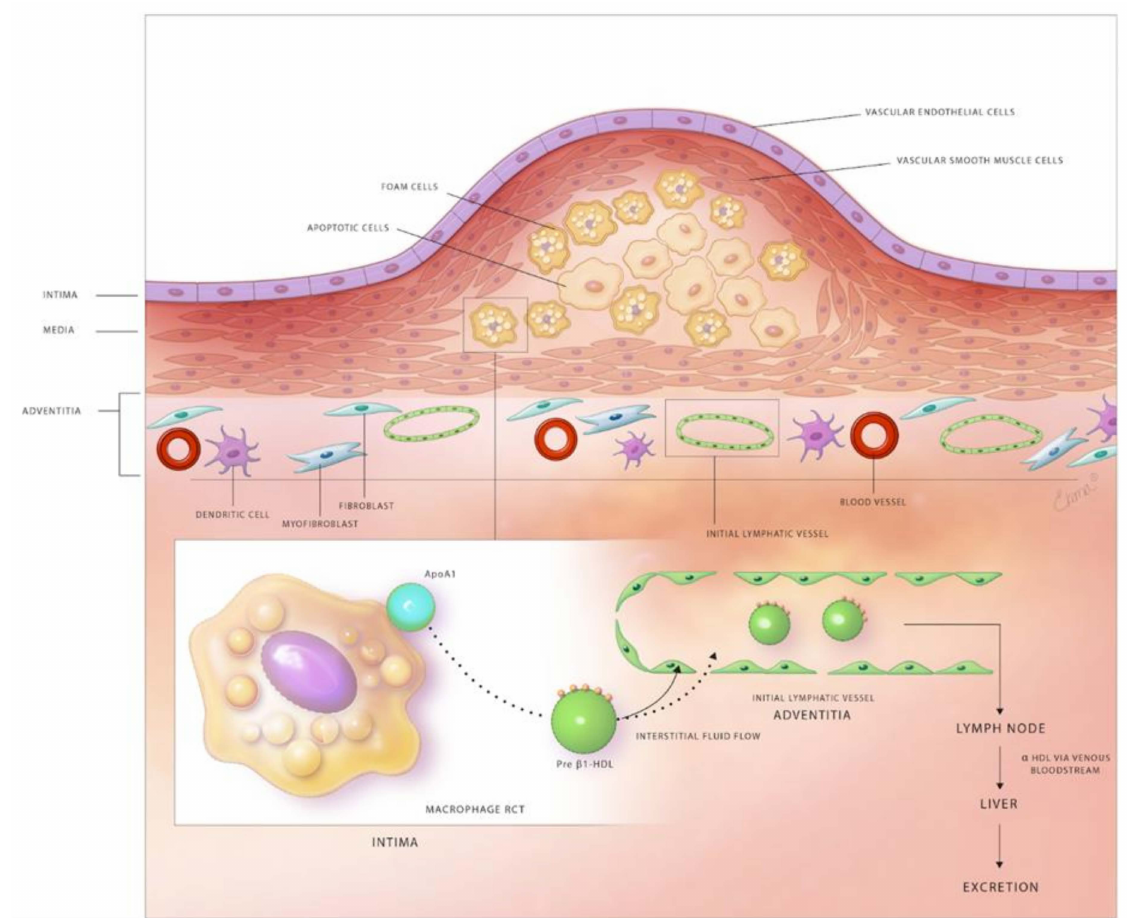
Figure 1. Schematic diagram depicting the role of lymphatic vessels in reverse cholesterol transport in the atherosclerotic arterial wall. Subendothelial lipid-laden foam cells e ffl ux free cholesterol through the plasma membrane transporters, ABCA1 and ABCG1. The exported free cholesterol is taken up by the apoA1 component of HDL to form pre- β 1 HDL. Pre- β 1 HDL moves from atherosclerotic lesions to the adventitial area, where lymphatics exist via the flow of interstitial fluid. Pre- β 1 HDL lipoproteins enter the lymphatic circulation either by SR-B1-mediated transcytosis across LECs of initial lymphatics or via paracellular transport between LECs. Semilunar lymphatic valves between lymphangions, endogenous forces provided by the contraction of lymphatic SMCs, and exogenous forces, including skeletal muscle contractions, arterial pulsation, and inspiration maintain the unidirectional flow of lymph through the lymphatic network. Pre- β 1 HDL finally reaches the low-pressure venous circulation via the subclavian vein(s), becomes modified to α -HDL, which is then internalized by hepatic cells and excreted into the gastrointestinal